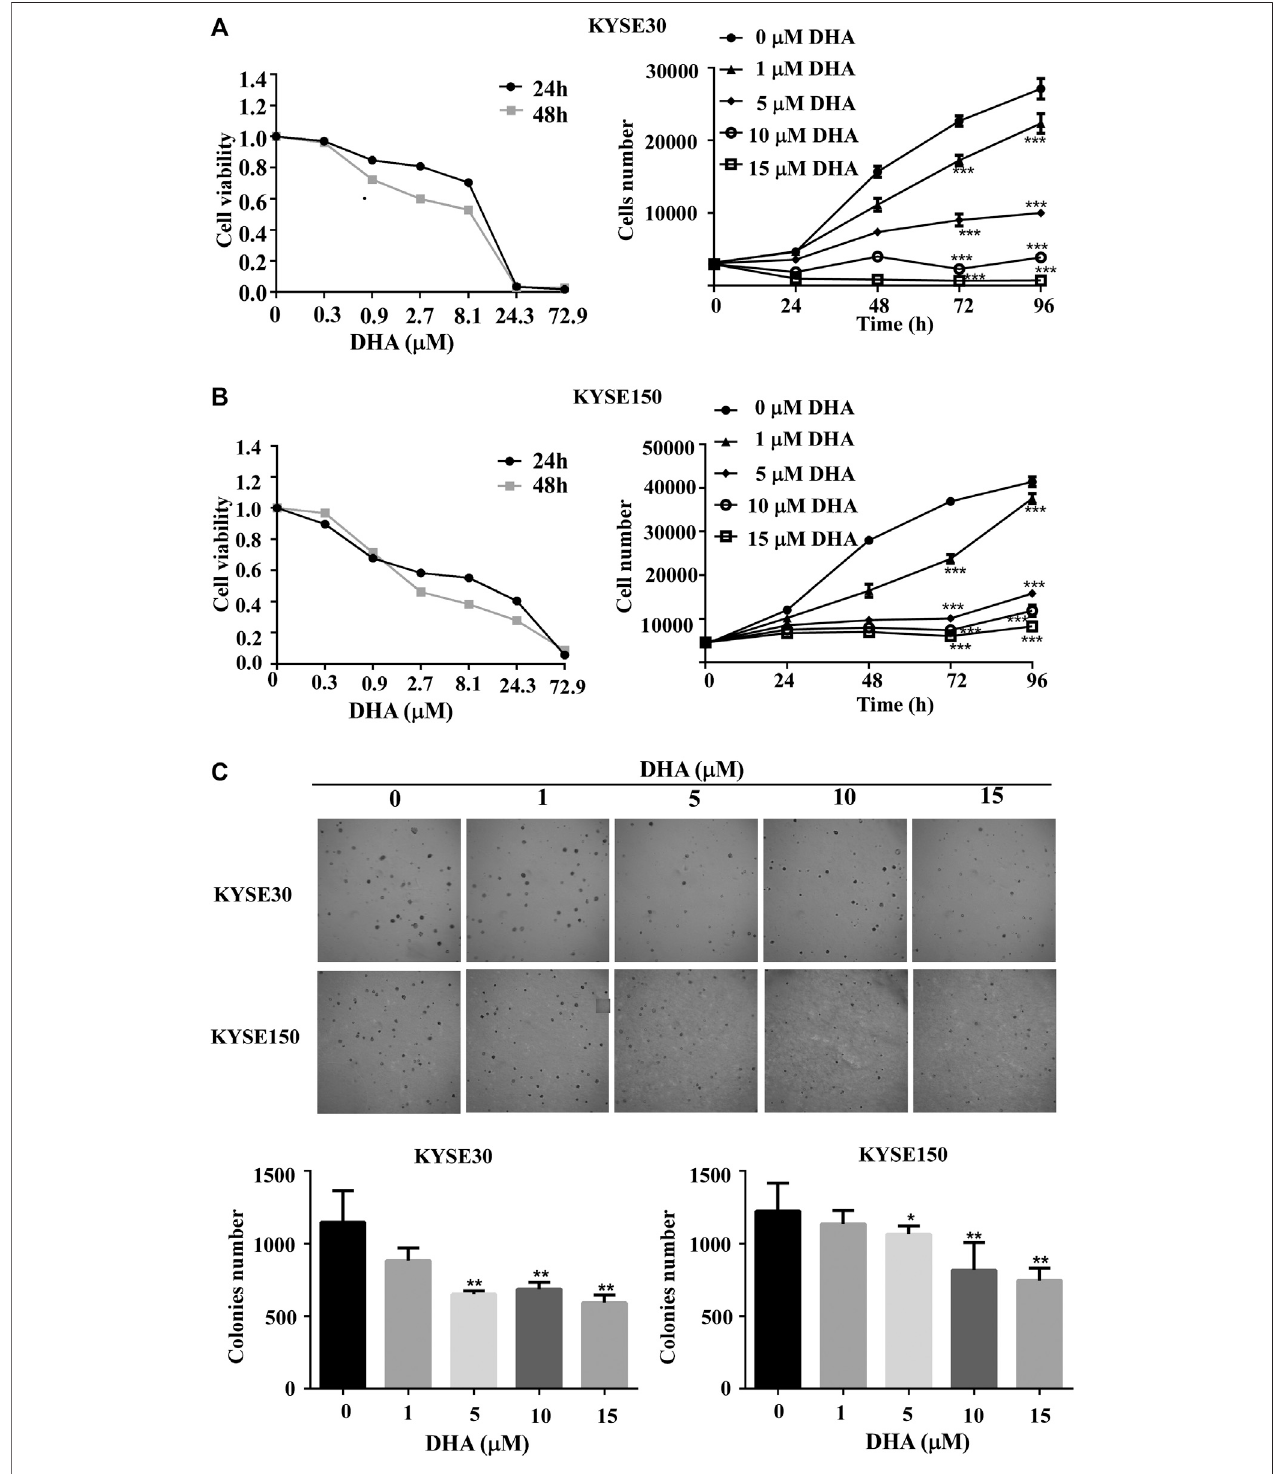
FIGURE 1 | DHA inhibits proliferation and anchorage-independent growth of ESCC cells. (A) Toxicity (left panel) and growth inhibition (right panel) of DHA on KYSE30 cells.Thenumber ofcellswasassessedbyINCell Analyzer6,000.Dataarepresentedasmeans ± SD. (B) Toxicity(leftpanel) andgrowth inhibition(rightpanel) ofDHA on KYSE150 cells. (C) DHA inhibited the colony-forming abilityofESCC cells. KYSE30 and KYSE150 cells were treatedwithDHA (0, 1,5, 10and 15 μ M) in agar gel about 8 days respectively and the representative images are shown. The colony numbers of KYSE30 and KYSE150 were measured via In Cell 6,000 Analyzer. Data are presented as means ± SD (*, p < 0.05; **, p < 0.01; ***, p < 0.001) compared with the control group, n (cid:2) 3 per group,one-way ANOVA).